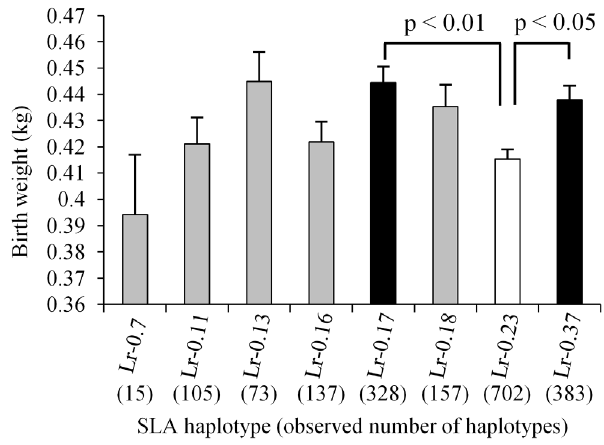
Figure 1. Comparison of birth weights of Microminipigs with eight different swine leukocyte antigen (SLA) class II haplotypes. Columns and bars indicate means and standard error, respectively. The number of haplotypes was counted as two in homozygous individuals. White and black columns represent the lower (Lr-0.23) and higher mean values (Lr-0.17 and Lr-0.37, respectively) with significant differences among haplotypes, respectively. Gray columns represent mean values that did not differ significantly from those of other haplotypes.